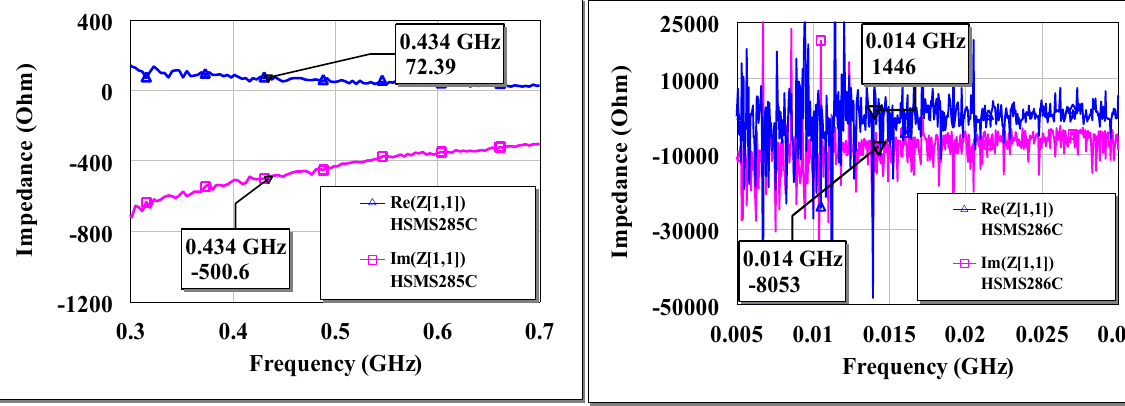
Figure 3. Measured input impedance (Δ resistive, □ capacitive) of HSMS-285C ( left ) and HSMS-286C ( right ) diodes at −30 dBm input with 1 MΩ load and 100 pF